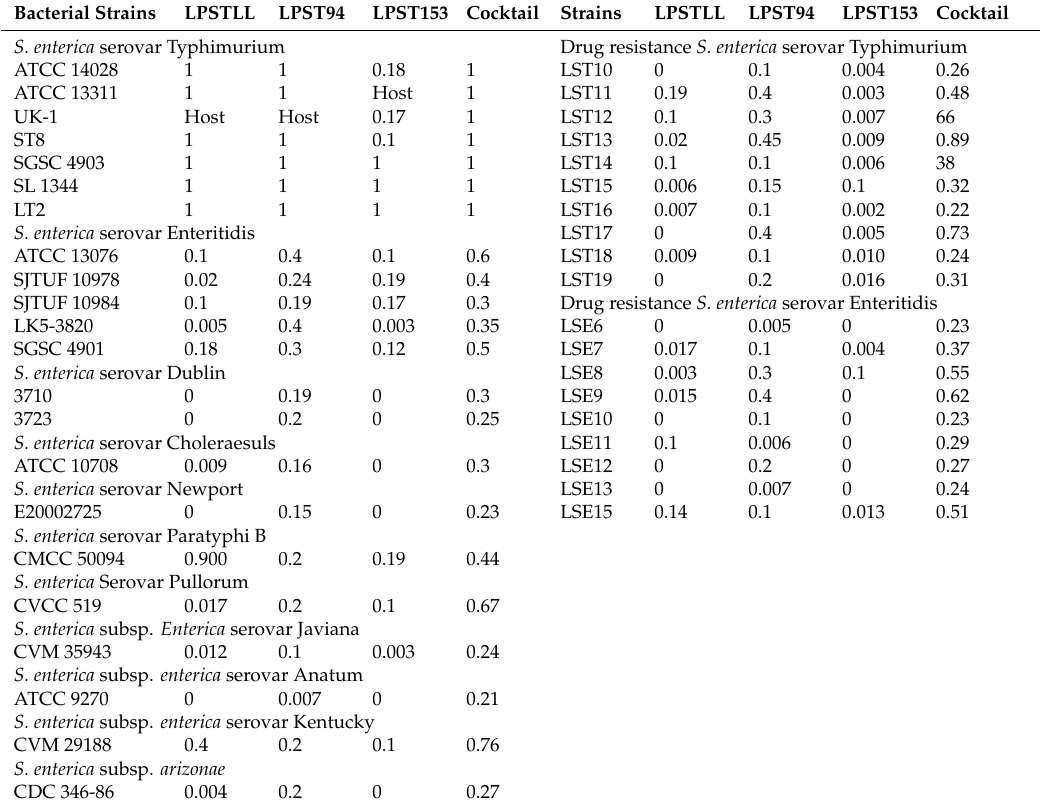
Table 3. E ffi ciency of plating (EOP) by phages (LPSTLL, LPST94, LPST153 and cocktail) against di ff erent Salmonella